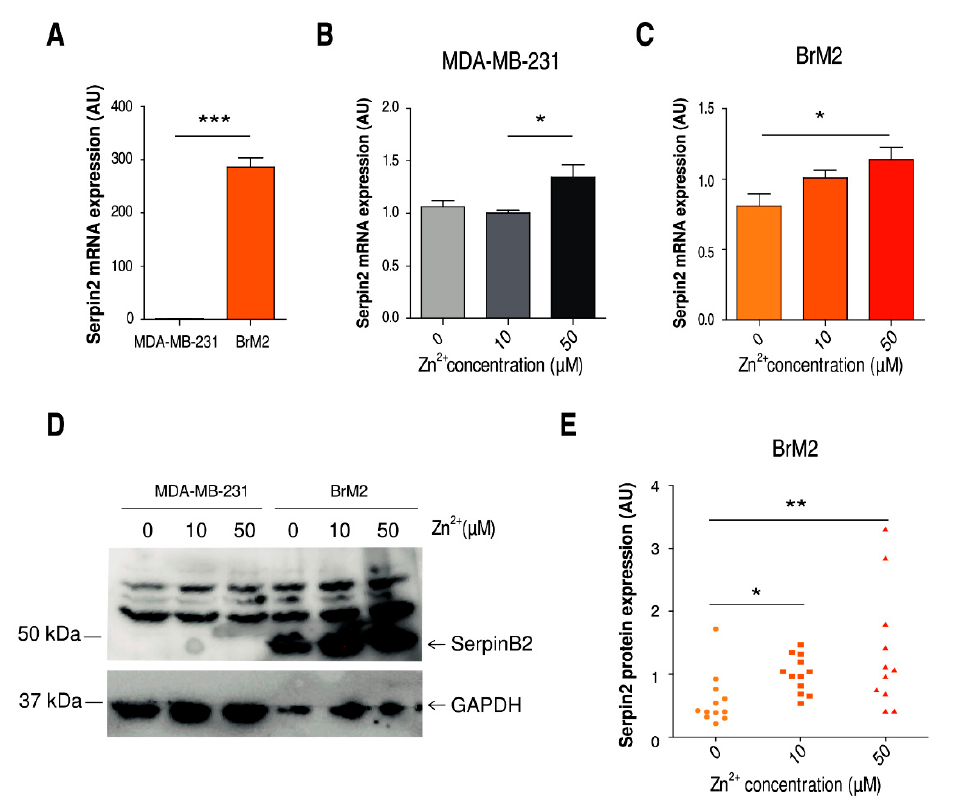
Figure 3. Characterization of SerpinB2 expression at the mRNA and protein level in MDA-MB-231 and BrM2 cells ( A ) RT-PCR comparing SerpinB2 expression in MDA-MB-231 and BrM2 cells in basal conditions. 2-DDCT plotted using GAPDH as the housekeeping gene and MDA-MB-231 as the control line (n = 9); *** p < 0.001 using t-test. ( B , C ) RT-PCR comparing SerpinB2 in 0, 10, and 50 µM of ZnSO 4 after 24 h of treatment. 2-DDCT plotted using GAPDH as the housekeeping gene and normalized to the 10 µM condition of each cell line (n = 6); * p < 0.05 using ANOVA and Tukey’s multiple comparison test. ( D ) Representative Western blot against SerpinB2 and GAPDH in MDA-MB-231 and BrM2 after 24 h of treatment with 0, 10, and 50 µM of ZnSO 4 . ( E ) Quantification of SerpinB2 protein expression normalized by GAPDH protein expression in BrM2 cells after 24 h of treatment with 0, 10, and 50 µM of ZnSO 4 (n = 11–12); * p < 0.05, ** p < 0.01 using Dunn’s multiple comparison test.